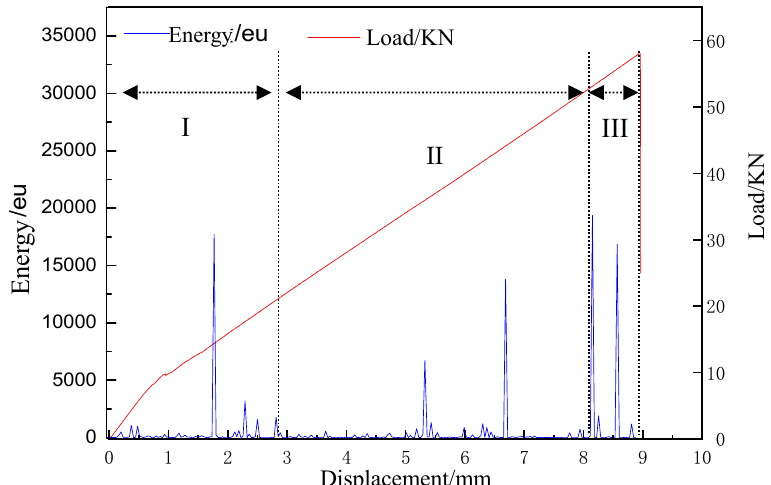
Figure 3. Change in the load-displacement curve corresponding with the acoustic emission (AE) ignal energy parameter of carbon fiber braided composites.